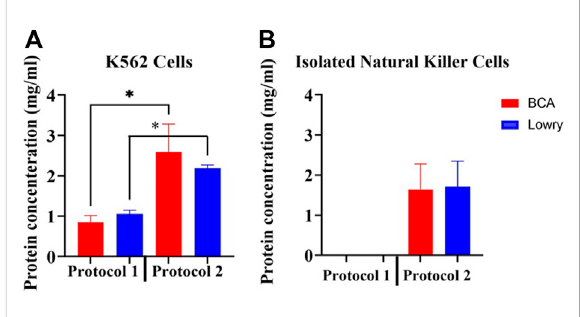
FIGURE 2 Determination of protein extraction ef fi ciency by the two adapted protocols. (A) Comparison of average total membrane protein yield from cultured K562 cells using the two adapted protocols. 2 × 10 6 K562 cells were used per sample. For both protocols, protein quanti fi cation was performed using the Pierce BCA and Bio-Rad DC protein assays simultaneously using a NanoDrop spectrophotometer. Normality was determined using the Shapiro Wilk test ( p > 0.05). Data is represented as the mean ± SEM as determined by independent t -test. * p < 0.05. (B)